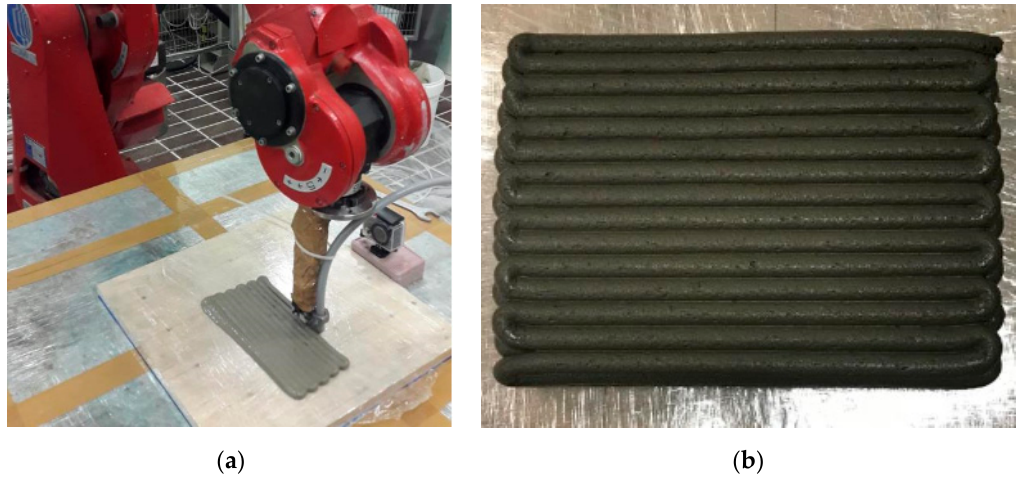
Figure 8. Printability test: slab extrusion process ( a ) and consistency of the optimum fresh mix ( b ) .